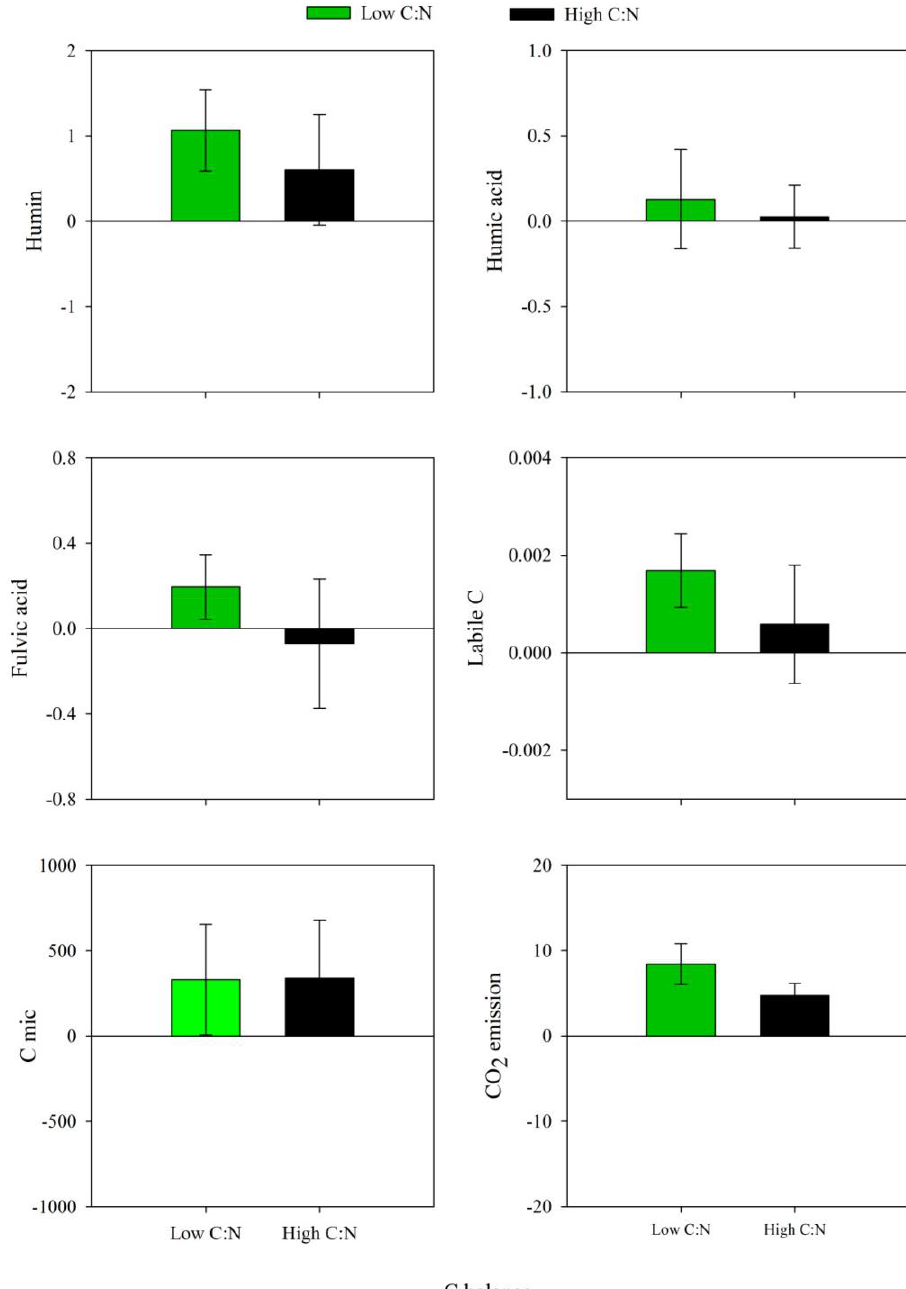
Figure 4. Stock balance of humin (g kg − 1 ), fulvic acid (g kg − 1 ), humic acid (g kg − 1 ), labile carbon (g kg − 1 ), microbial biomass carbon (C mic, µ g g − 1 ha − 1 ), and CO 2 emissions (g CO 2 m − 2 h − 1 ). The stock was calculated according to the difference in C contents in 50-day and initial soil C (day